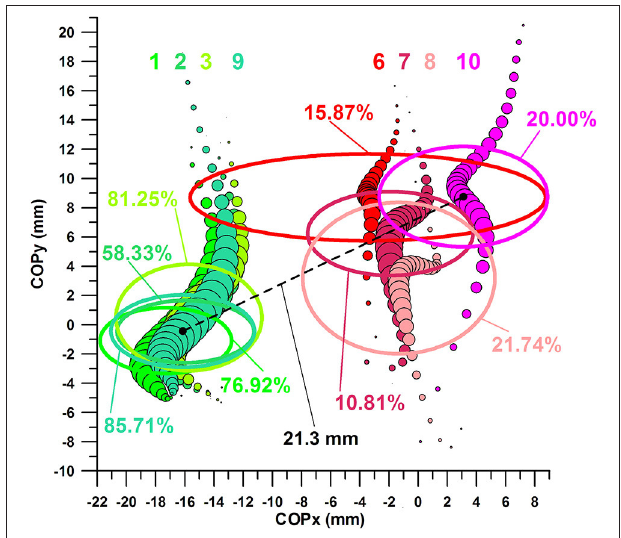
FIGURE 13 | Sweet spot and dead spot; ellipses [one standard deviation about the average (black dots in the center of ellipses of sets 9 and 10)] refer to COP location at